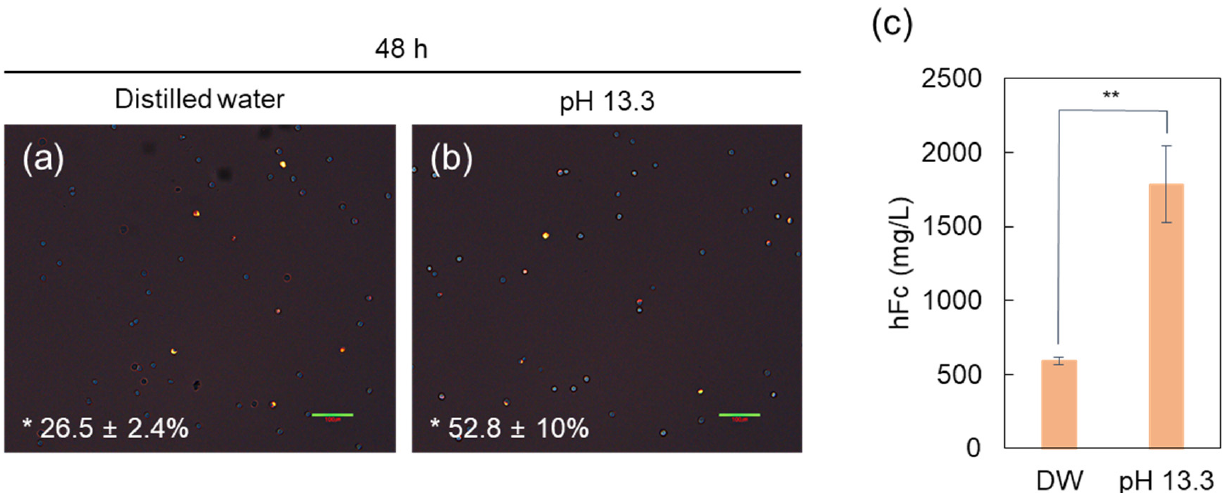
Figure 6. Fluorescence images ( a , b ) showing pDNA-positive cells at 48 h post-transfection. The number of cells containing pDNA among the cells was calculated using ImageJ software, and the percentage of pDNA-positive cells indicated in images is the average values of three individual images. Scale bar = 100 µ m. The hFc protein production ( c ) at 12 days post-transfection. The results represent the mean ± standard deviation ( n = 3). ** p < 0.01; hFc, human Fc protein; pDNA, plasmid DNA; DW, distilled water.